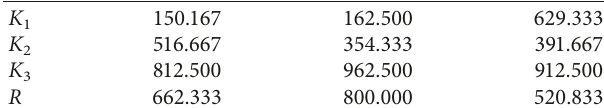
Table 4: Values of significance analysis.